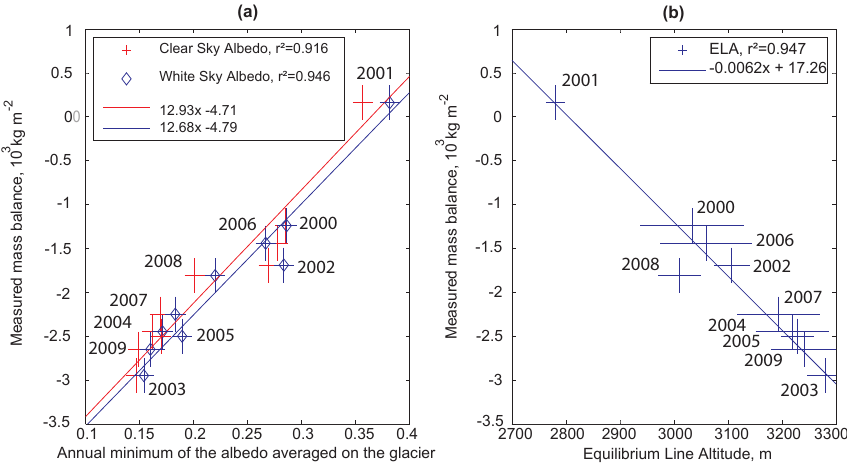
Fig. 6. Measured annual mass balance versus (a) the minimum of the mean glacier albedo and (b) the equilibrium line altitude for years 2000 to 2009. The RMSDs associated with each data points, the coefficients of determination r 2 and the regression lines calculated with the method described in York et al. (2004) are indicated on the charts. On the left panel the clear sky albedo is plotted in red crosses, whereas the white sky albedo is the blue